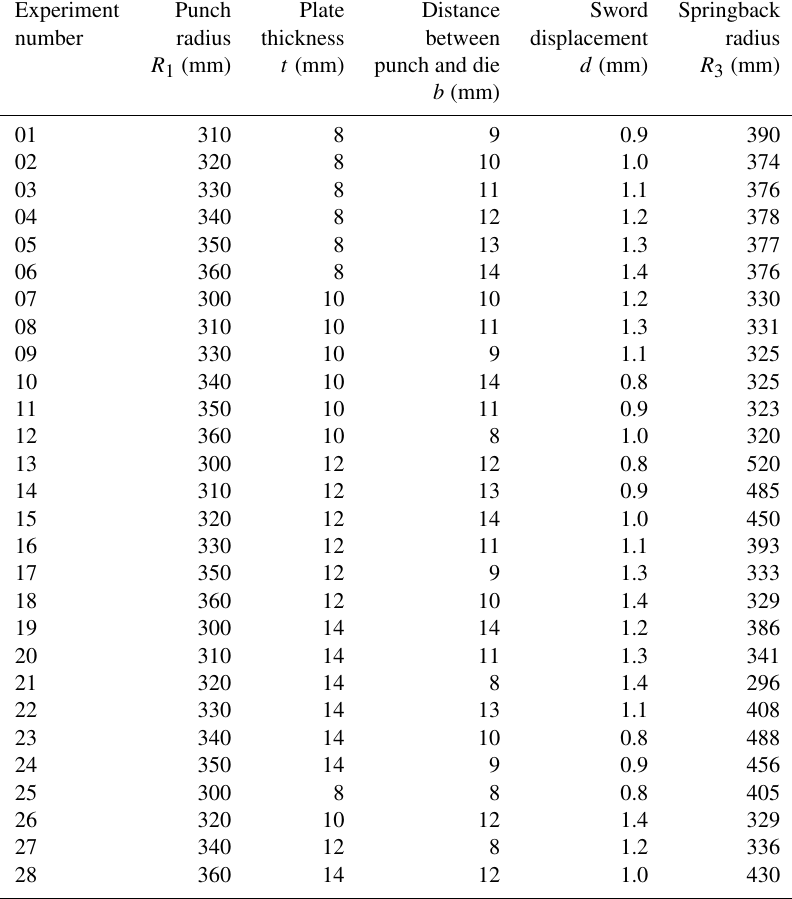
Table 3. Experimental